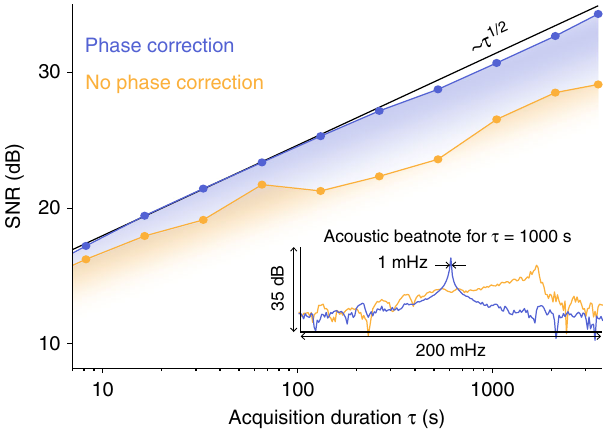
Fig. 3 Long-term acquisition. Signal-to-noise ratio (SNR) with (blue) and without (yellow) phase correction as a function of acquisition duration τ . The black line indicates the ideal case where the SNR increases proportionally to τ 1/2 . Inset: Central heterodyne acoustic beatnote spectrum for τ = 1000 s with(blue) and without (yellow) phase